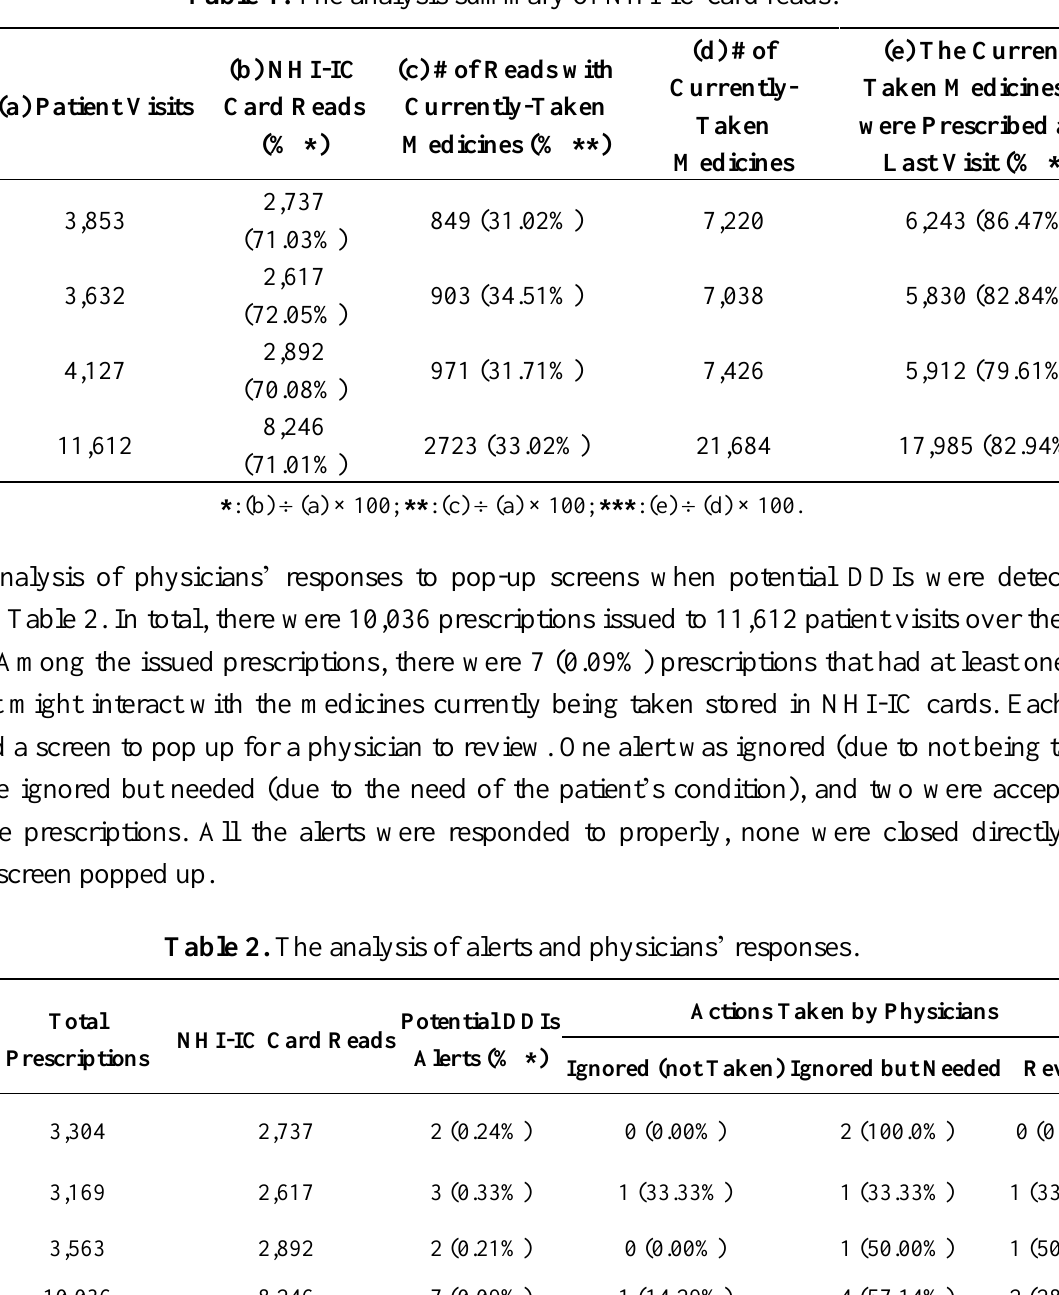
Table 1. The analysis summary of NHI-IC card reads.